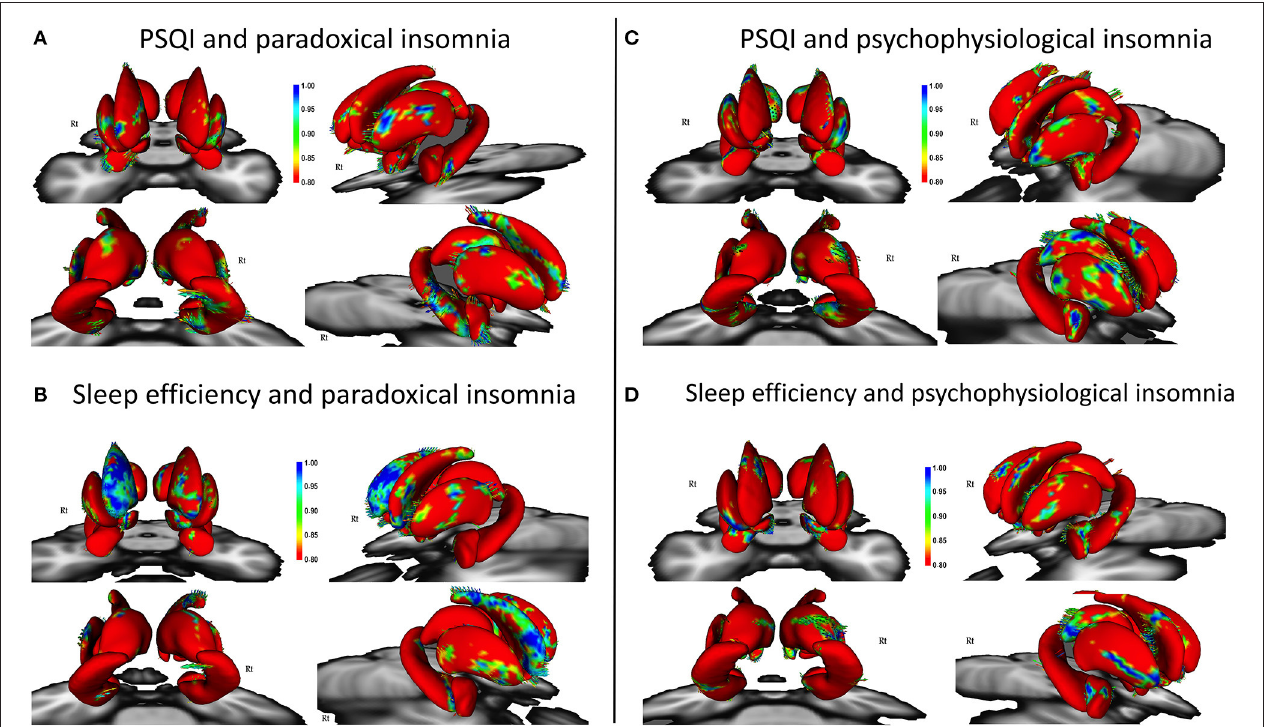
FIGURE 2 | Correlation of Pittsburgh Sleep Quality Index (PSQI) and sleep efficiency with surface changes in patients with paradoxical insomnia (A,B) ; Correlation of PSQI and sleep efficiency with surface changes in patients with psychophysiological insomnia (C,D) including covariates of no-interest (i.e., age, gender, and total brain volume). Color bar shows false discovery rate (FDR) corrected p